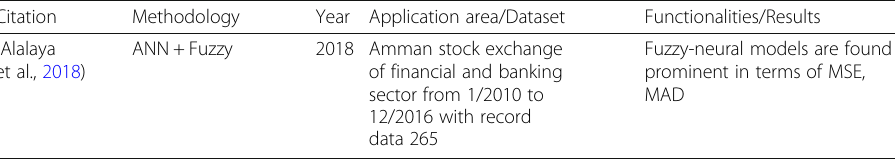
Table 1 Review of ANN articles on financial time series prediction (Continued)